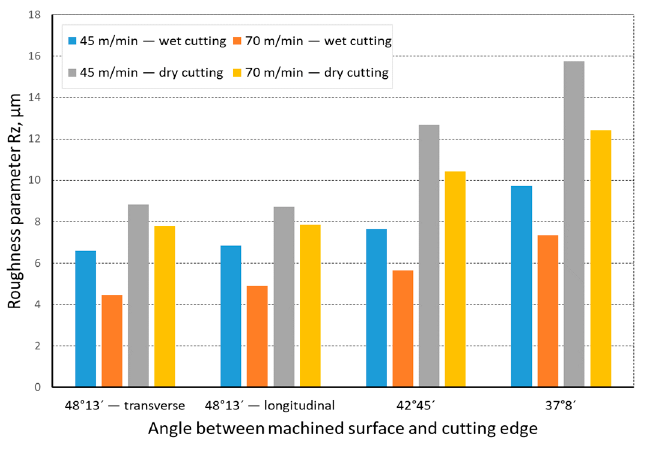
Figure 7. The impact of cutting speed on the variability of roughness parameter Rz in the function of the angle between the machined surface and cutting edge for a rectilinear track and a material hardness of 36 HRC.